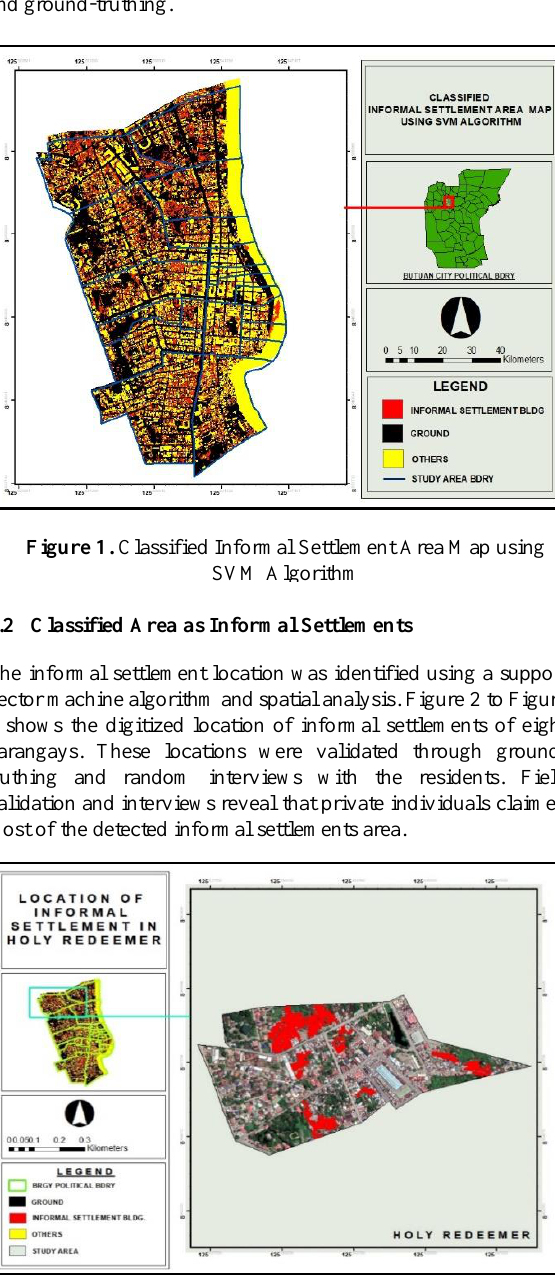
Figure 2. Informal Settlement in Brgy. Holy